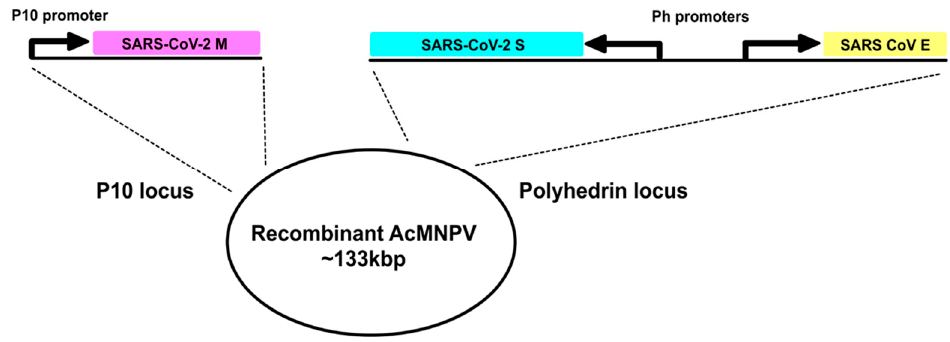
Figure 1. A schematic representation of the gene arrangements in the transfer vectors used to generate the recombinant baculovirus expressing SARS-CoV-2 VLPs. The SARS-CoV-2 M protein was expressed from the P10 promoter integrated at the P10 locus of the AcMNPV genome while S and E were expressed by back-to-back non-clashing polyhedrin promoters integrated at the polyhedrin locus of the genome.